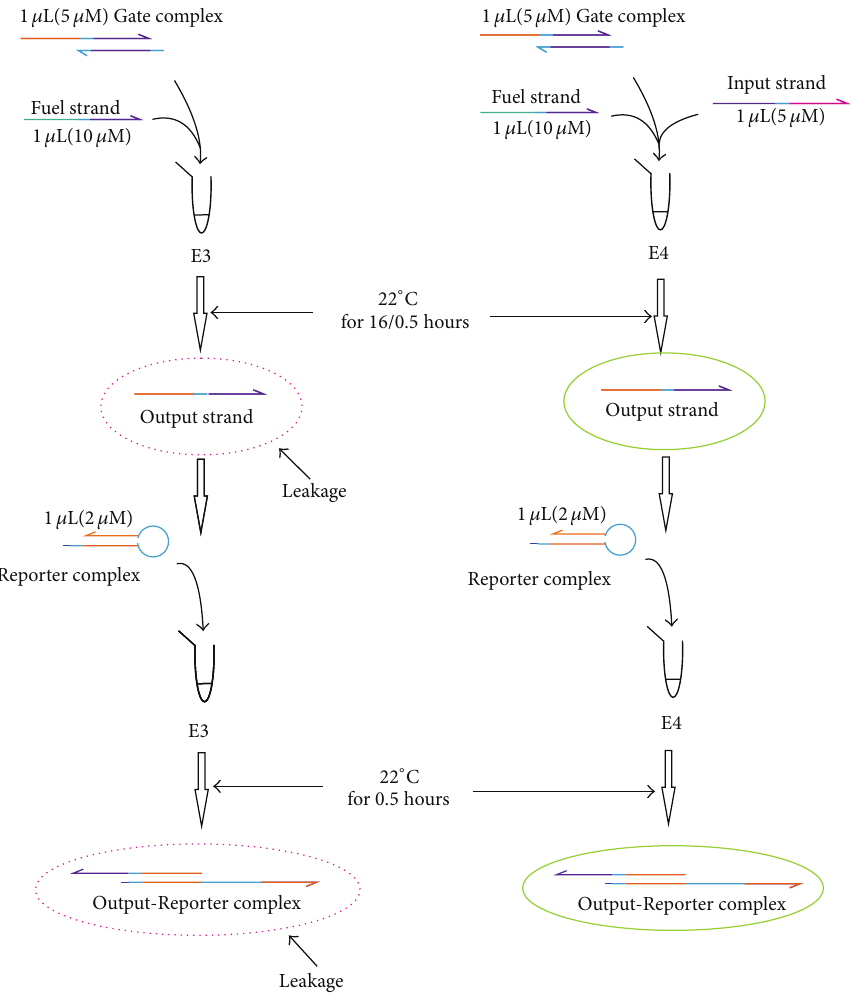
Figure 4: The procedures of experiments to analyze the influence of reaction time (16/0.5 hours) to leaky reaction of DNA strand